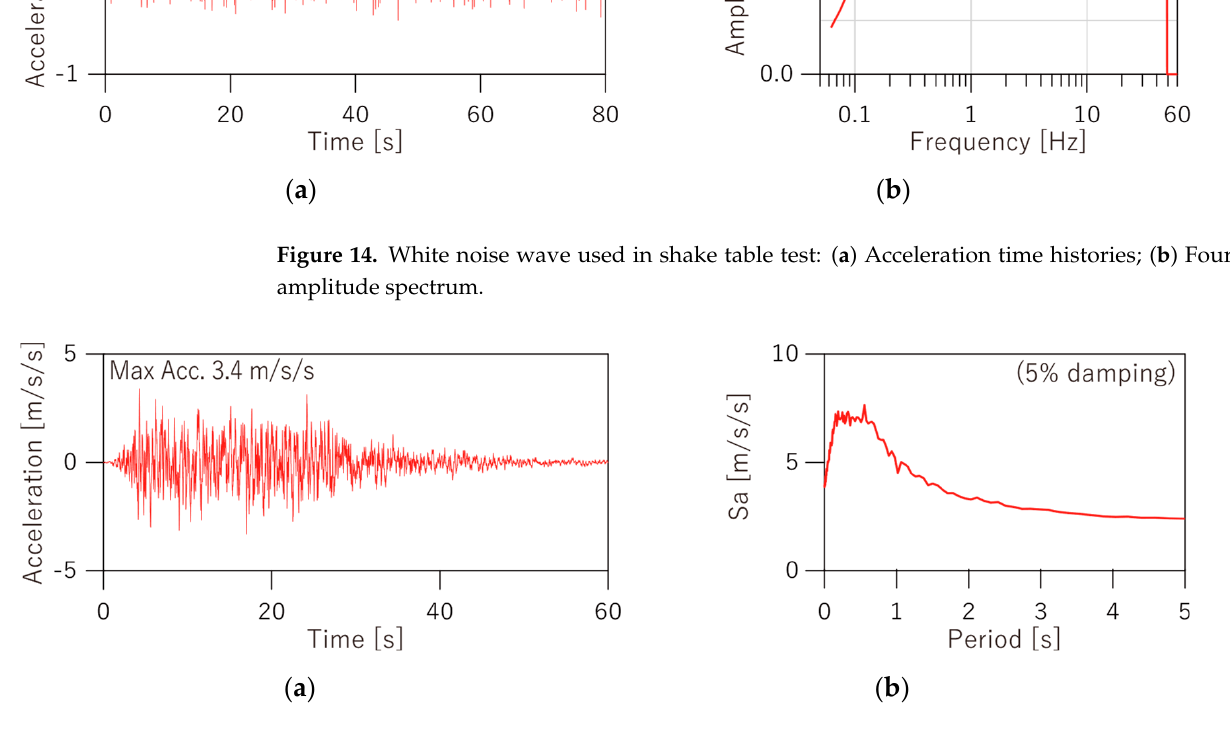
Figure 15. Simulated earthquake wave used in shake table test: ( a ) Acceleration time histories; ( b ) spectral acceleration.